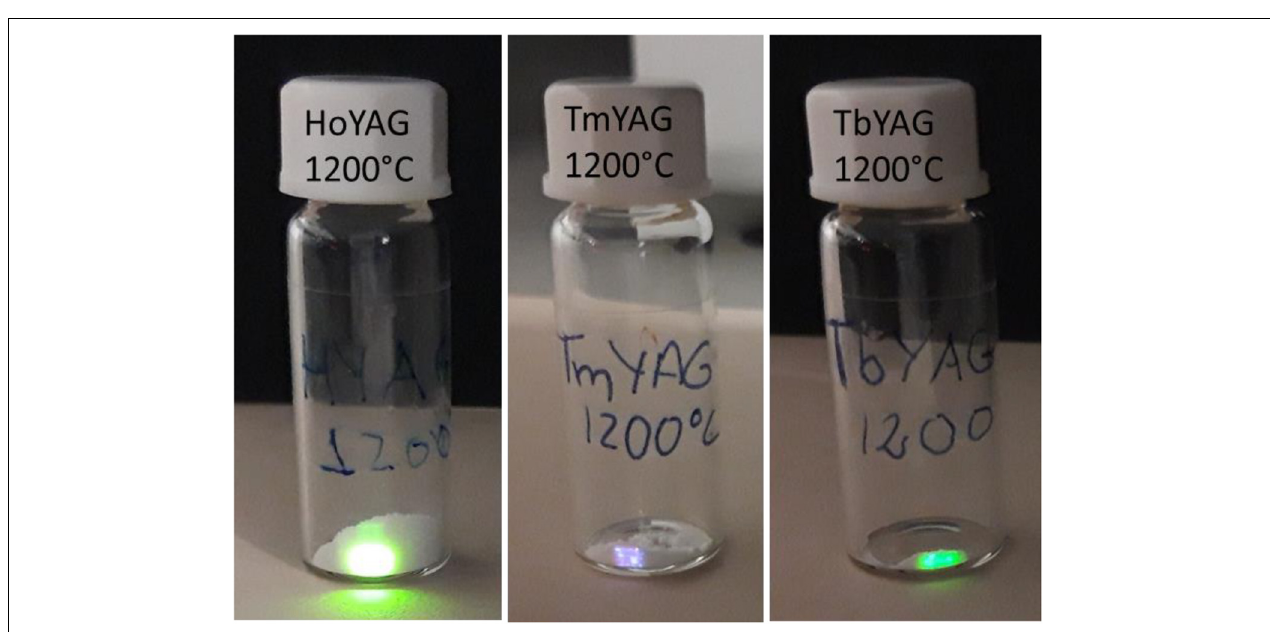
FIGURE 6 | Pictures of the green and blue emission observed at naked eye when the annealed powders are excited upon NIR excitation (980 nm). The pictures have been taken using a hot mirror filter between the camera and the